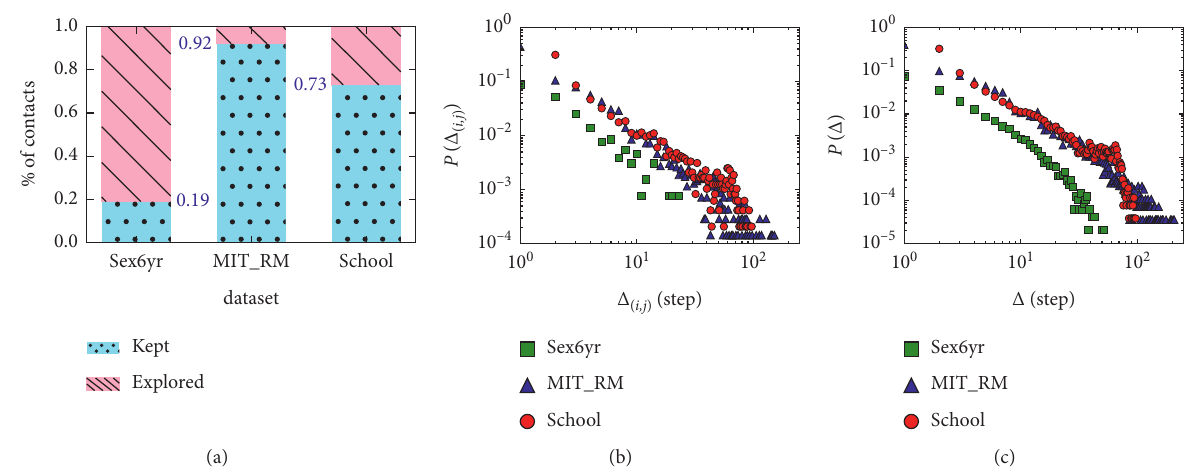
Figure 4: (a) Average fraction of social keeping contacts of each individual at each time step, with p � 19% (in Sex6yr), p � 92% (in MIR_RM), and p � 92% (in School). (b) Probability distributions P ( Δ ( i,j ) ) of the recurrence intervals Δ ( i,j ) of the contacts ( i, j ) for each individual i . Here, we plot the distribution for 10 individuals as an example. (c) The intercontact time distributions P ( Δ ) in empirical datasets, where Δ is the recurrence interval for any contact.